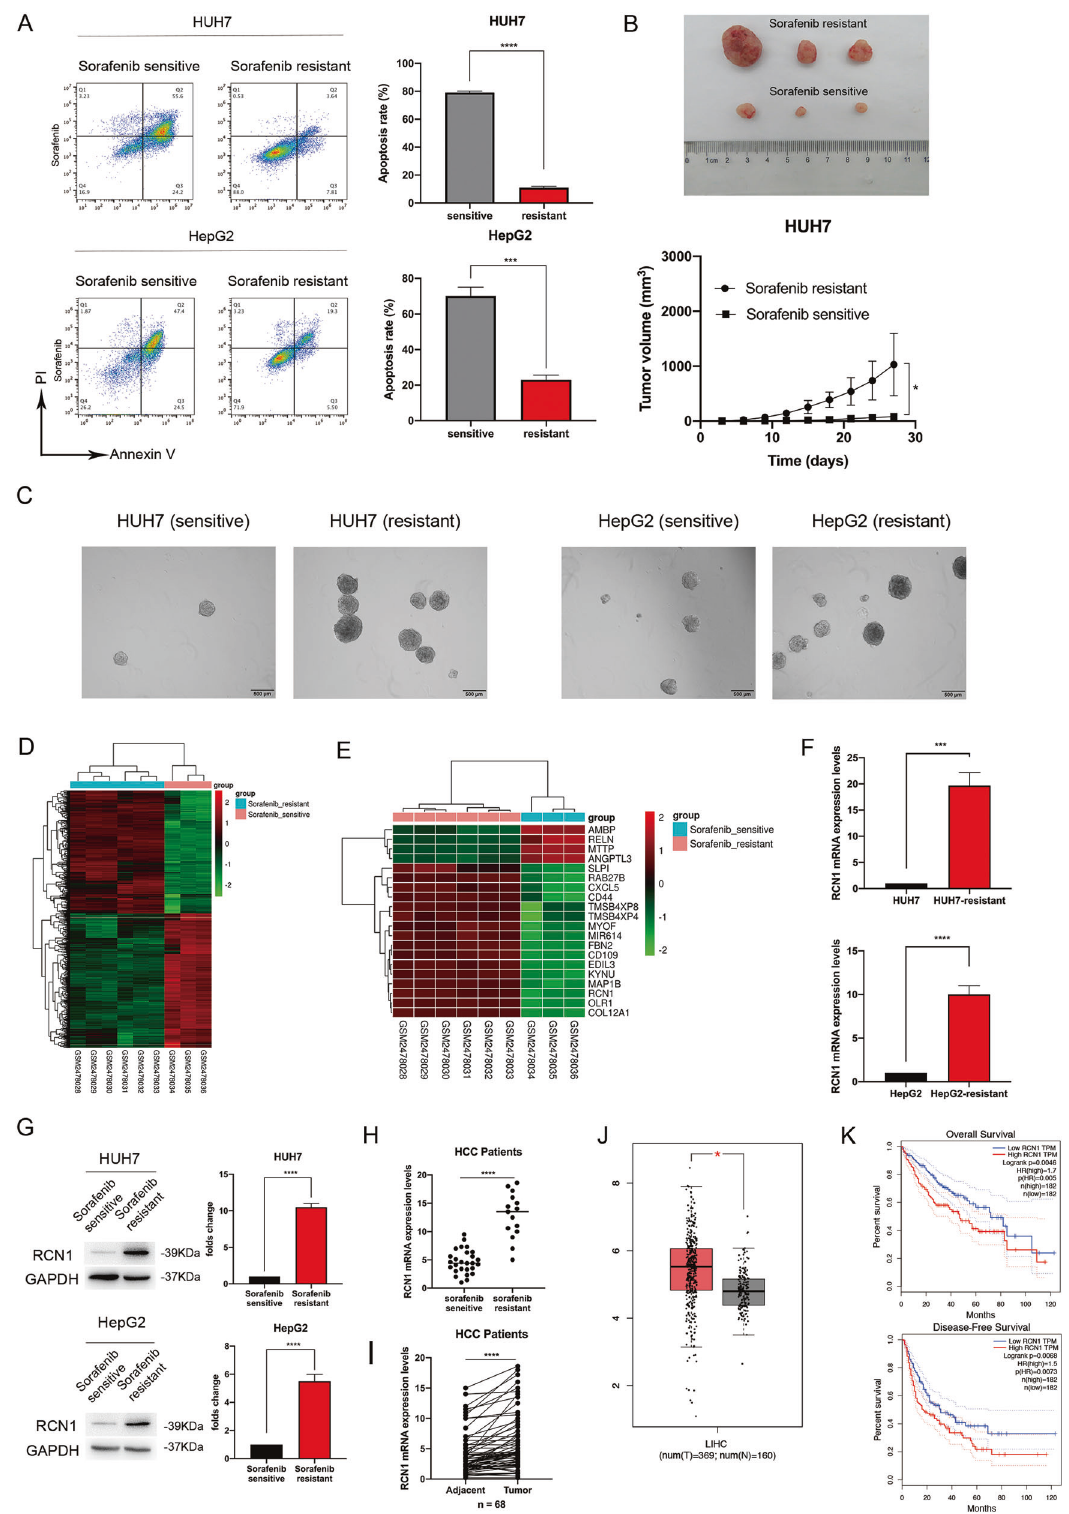
throughout the secretory pathway in mammalian cells [14]. RCN1 overexpression has been identi fi ed in various tumors, including liver, lung, breast, colorectal, prostate, and nasopharyngeal cancers [14 – 20]. In particular, RCN1 was implicated in the regulation of drug resistance, and RCN1 knockdown was